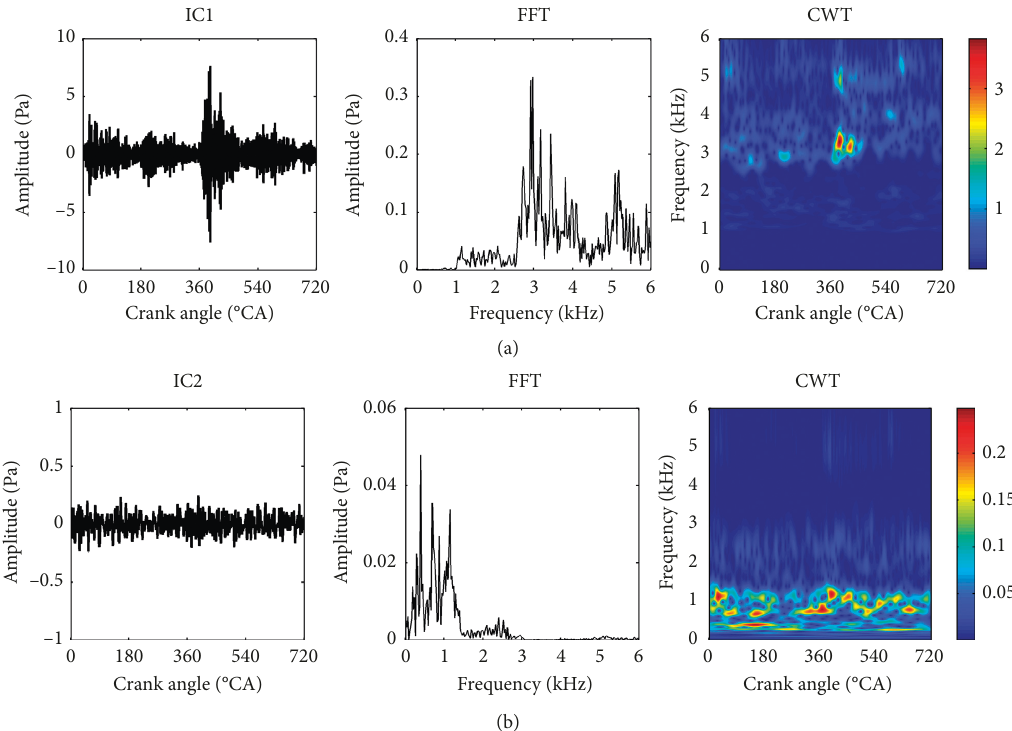
Figure 16: Time-domain waveform, spectrum, and time-frequency diagram of (a) IC1 and (b) IC2 from vice slap side noise signal y